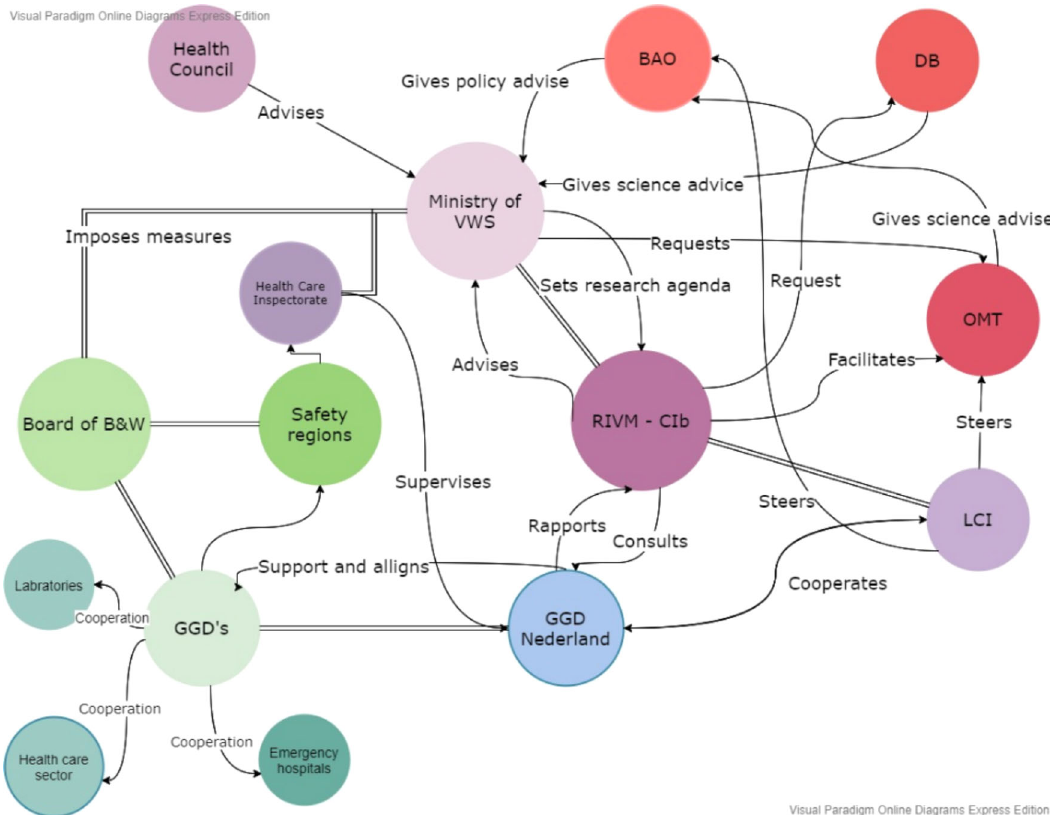
Fig. 2 Network of actors in the Netherlands in response to a pandemic.